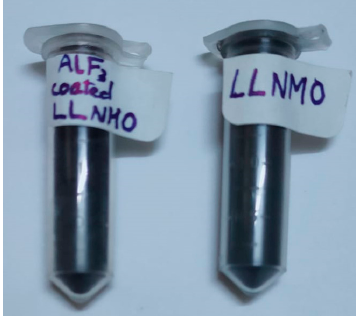
Figure 2. Photographs of pristine and AlF 3 -coated Li 1.2 Ni 0.2 Mn 0.6 O 2 specimens.